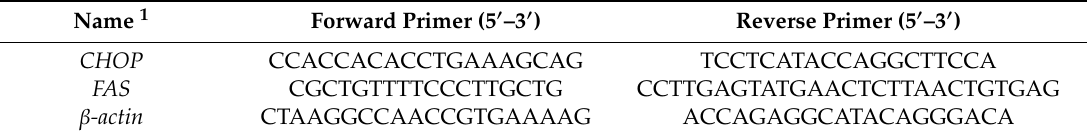
Table 1. Primers used for RT-PCR